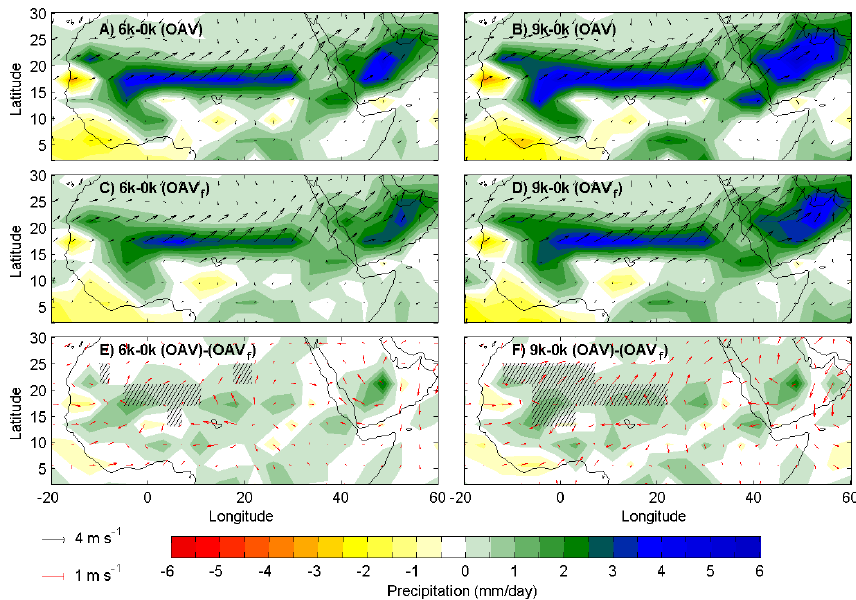
Figure 3. Changes in summer precipitation and near-surface winds for (a) the mid-Holocene and (b) the early Holocene experiment relative to PI in model simulations with dynamic vegetation. (c, d) : same as (a, b) but for fixed-vegetation simulations. (e, d) : differences between dynamic-vegetation and fixed-vegetation experiments. Hatched areas in (e, f) display significant precipitation differences (95% confidence